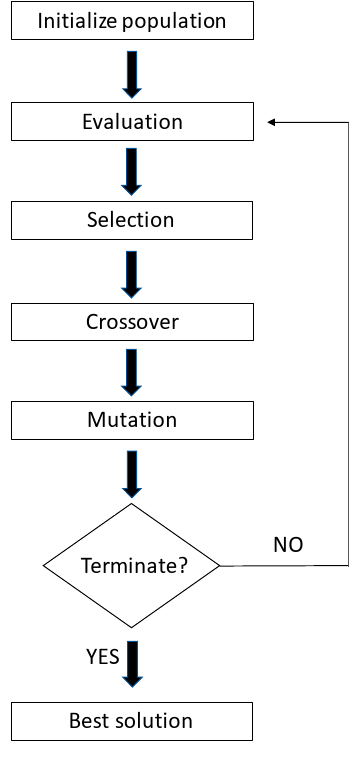
Figure 2. Flowchart of the proposed algorithm.